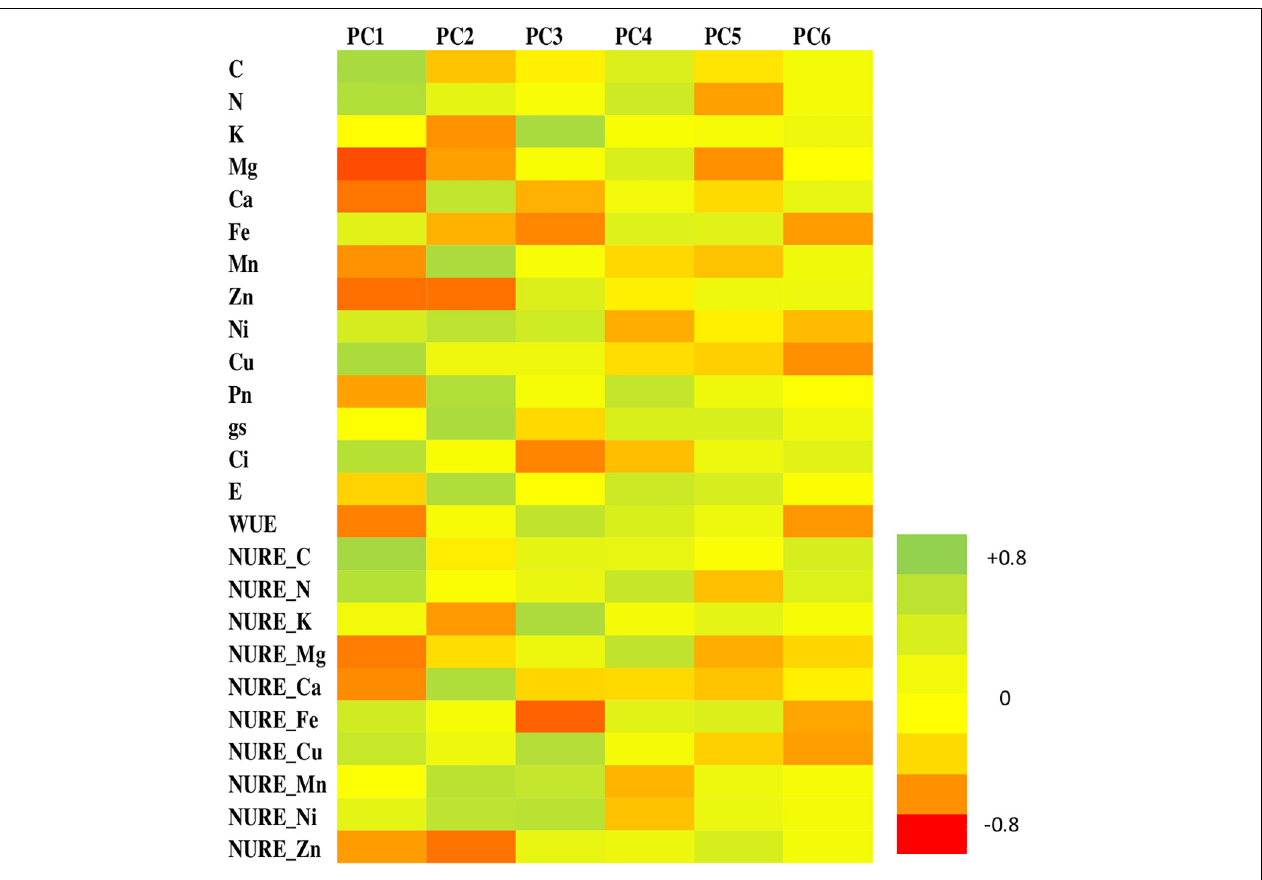
FIGURE 7 | Heat map of six principal components (PCs) showing respective loadings of the parameters during the experimental period.